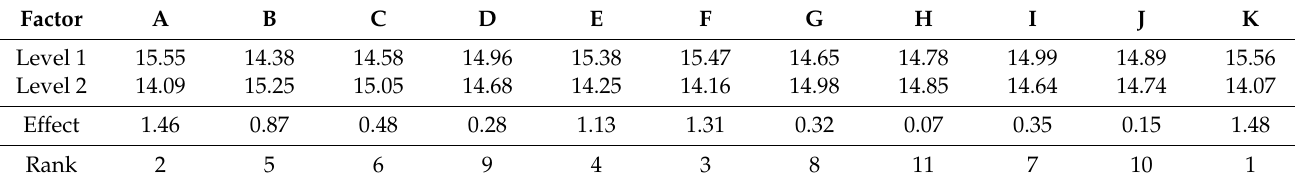
Table 6. Factor response table for the average luminance of the L 12 (2 11 )